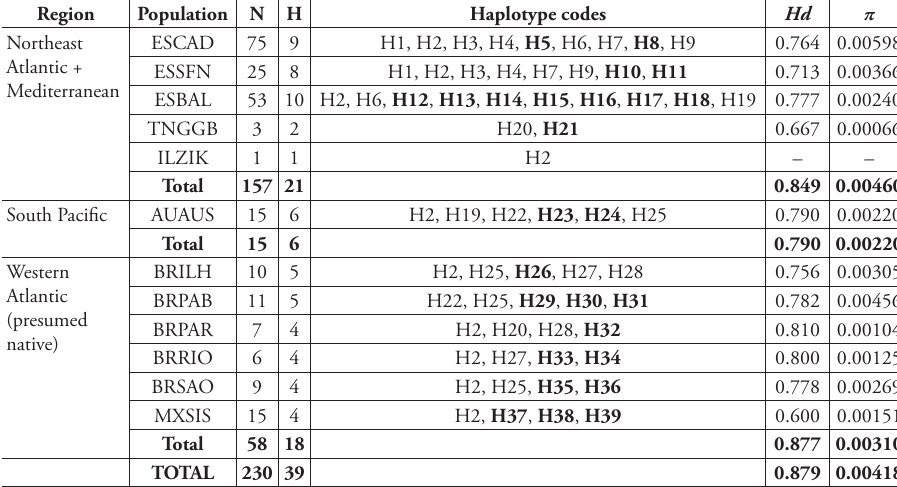
Table 3. Genetic diversity of Paracaprella pusilla for each sampling site and region. Number of individu- als per location (N), number of haplotypes (H), haplotype codes (private haplotypes indicated in bold ), haplotype diversity ( Hd ) and nucleotide diversity ( π